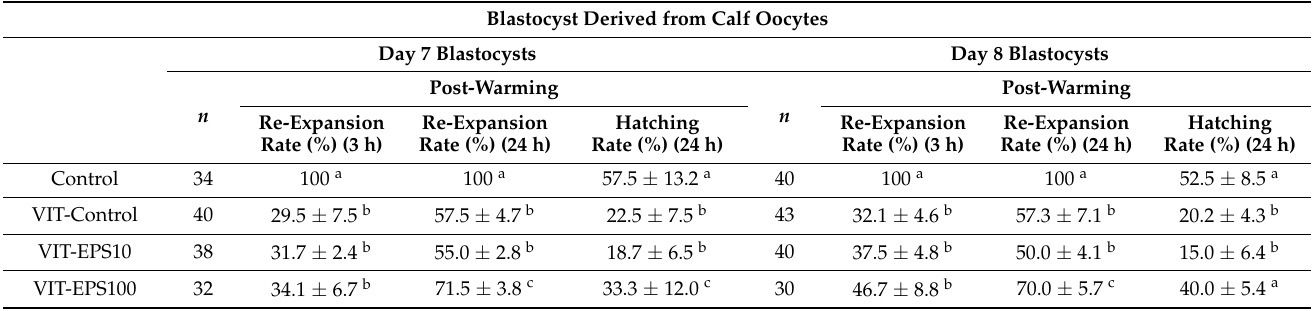
Table 2. Post-warming re-expansion and hatching rates of calf D7 and D8 expanded blastocysts after vitrification with VIT-Control, VIT-EPS10, and